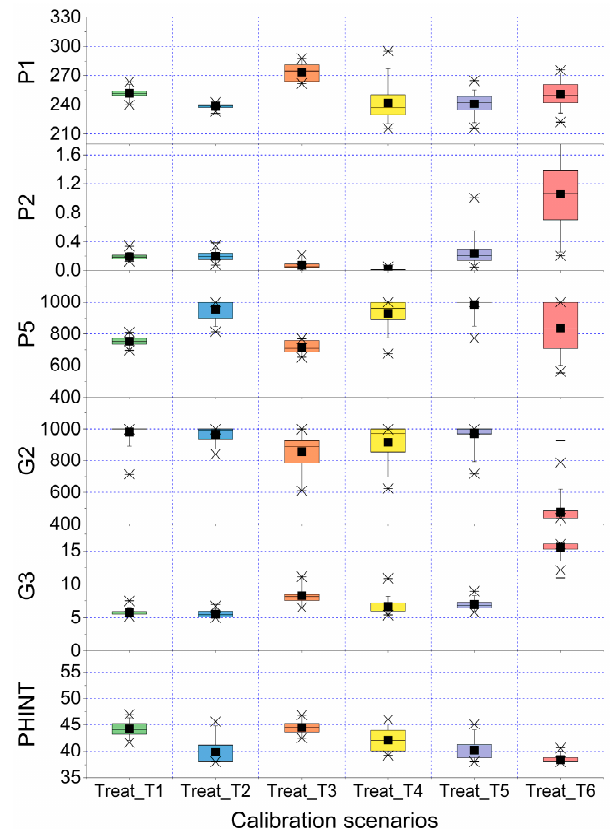
Figure 5. Variation in optimized maize cultivar parameters (P1, P2, P5, G2, G3, and PHINT as defined in Table 1) among the selected cases within 10% of calibrated Φ values from the 300 cases generated by the Latin hypercube sampling (LHS) for Treat_T1 to Treat_T6 in Table 3. The boxplots show the minimum and maximum values (asterisks), medians (lines), and means (dots). The 25% and 75% percentiles are shown as the tops and bottoms of the boxes, and the 5% and 95% percentiles are shown as the whiskers below and above the boxes.